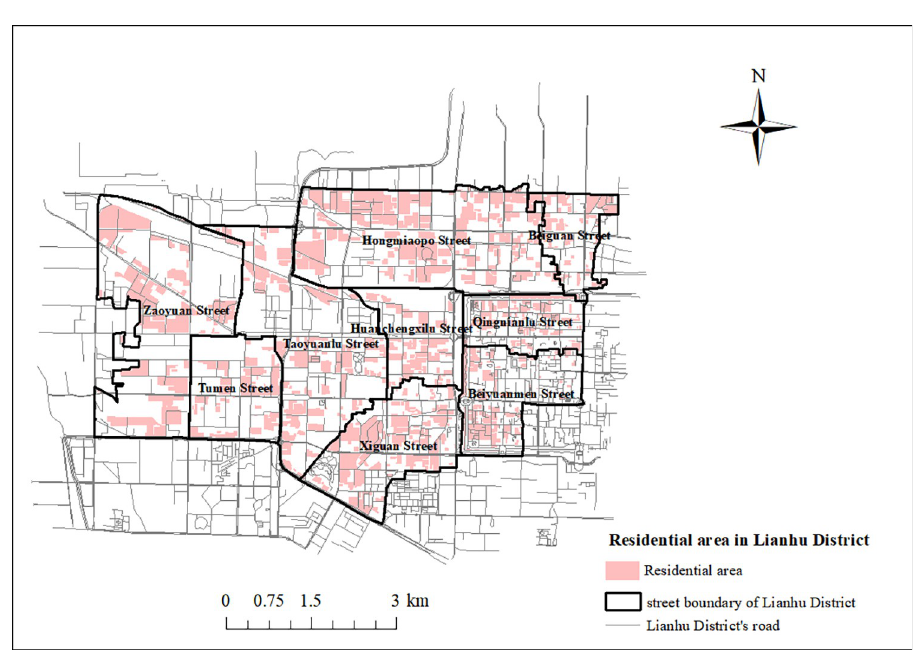
Fig 2. Street boundary map of Lianhu District.